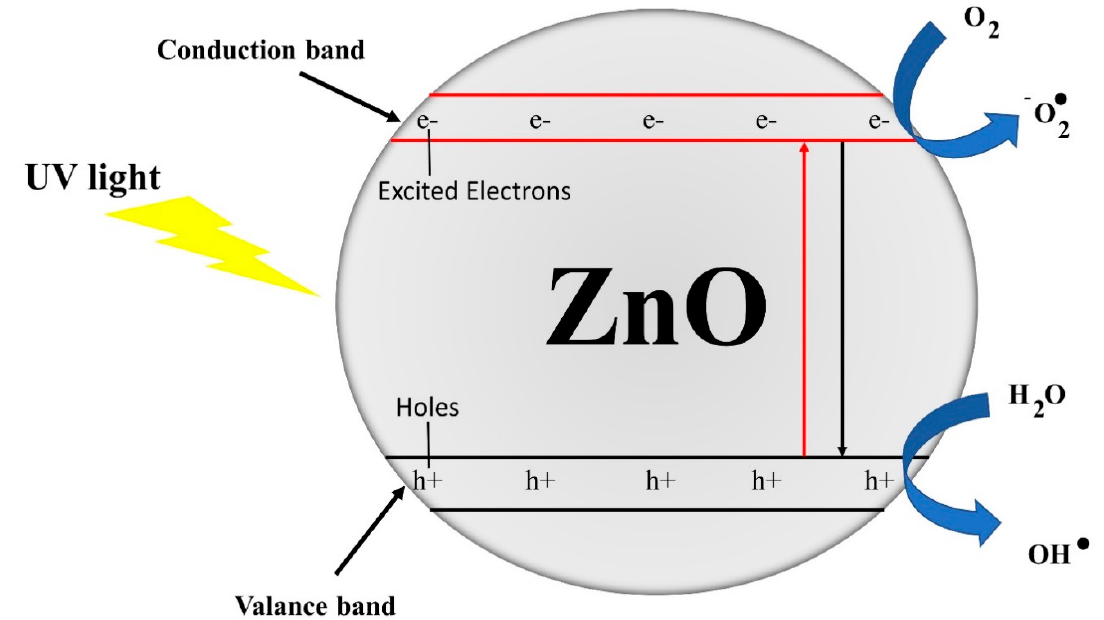
Figure 5. The proposed reaction mechanism on ZnO surface [29].